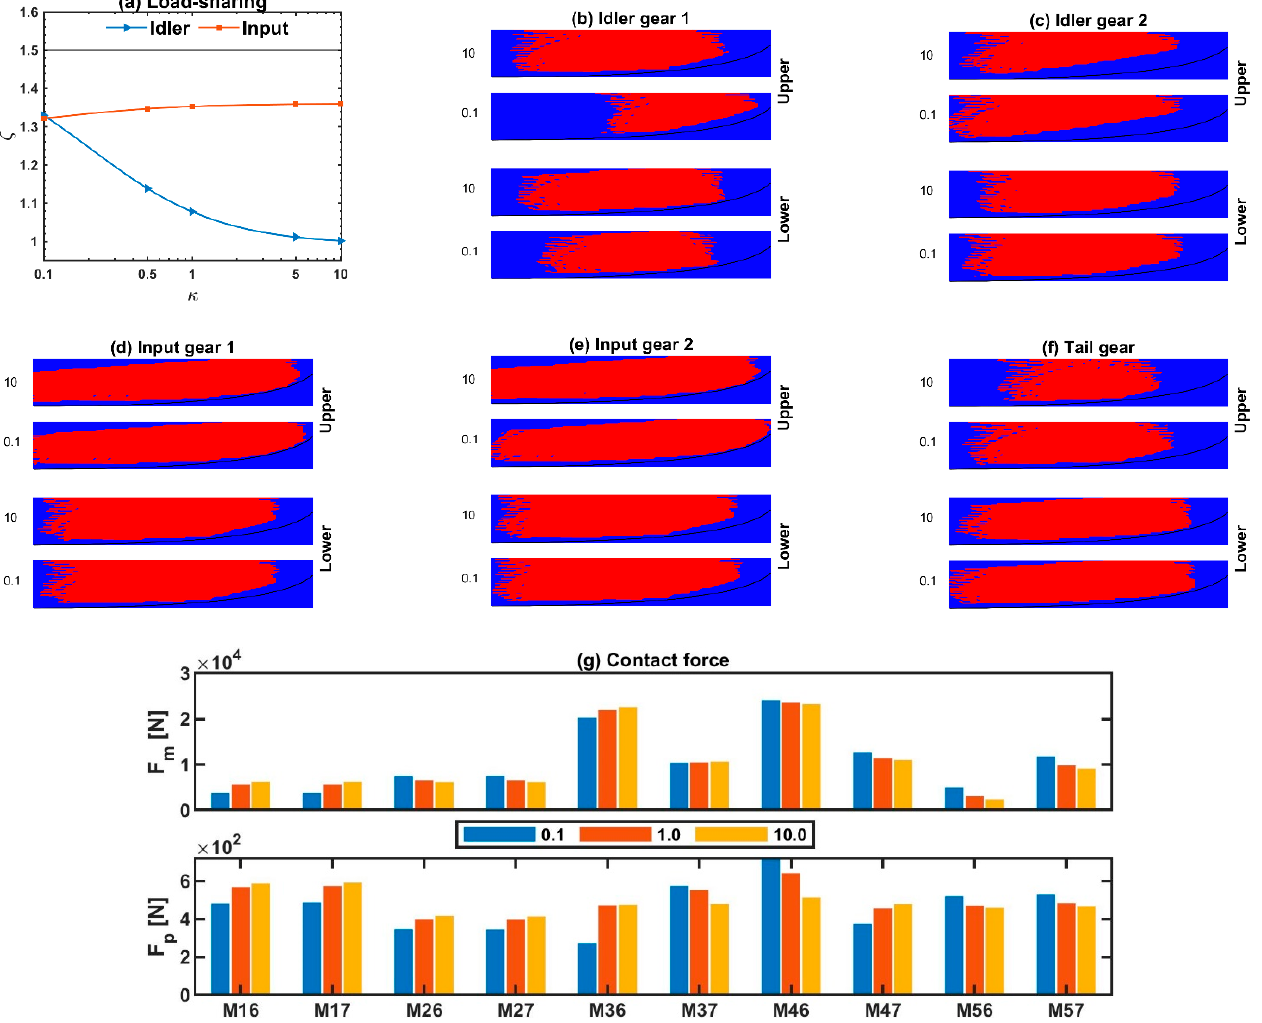
Figure 11. Influence of the support stiffness of the upper face gear on the load-sharing and contact characteristics.